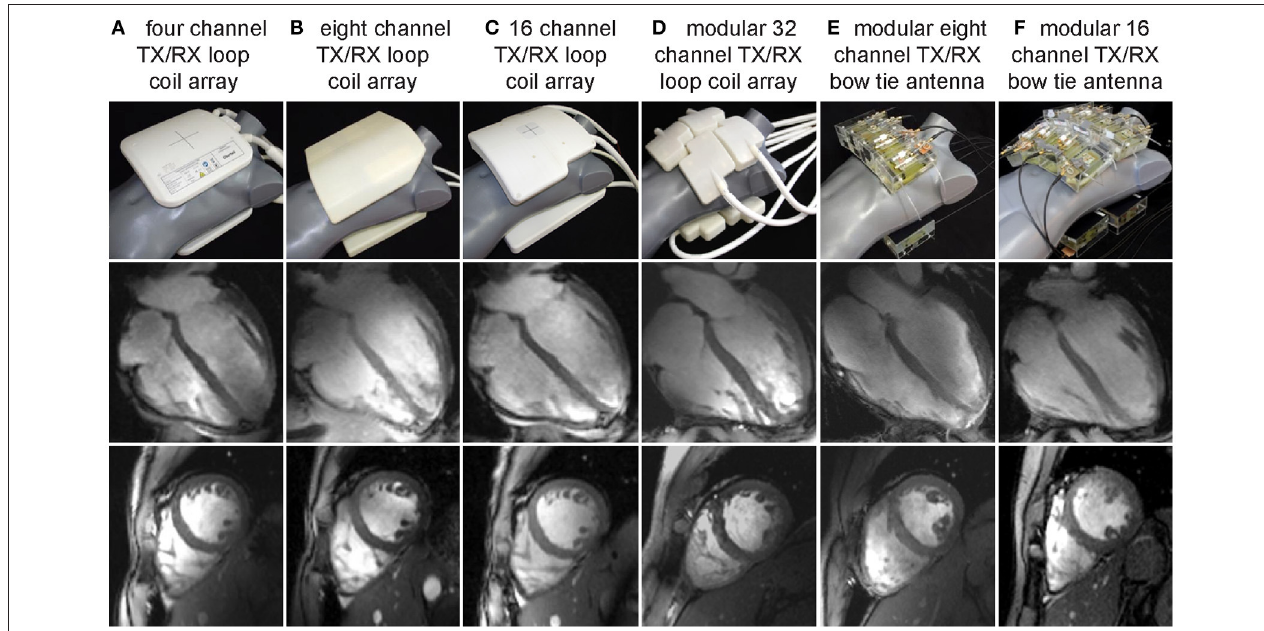
FIGURE 3 | Examples of multi-channel transceiver arrays tailored for cardiac MR at 7.0 T. Top: Photographs of cardiac optimized 7.0 T transceiver coil arrays including (left to right) (A) a four-channel, (B) an eight channel, (C) a 16 channel and (D) a 32 channel loop array configuration together with an (E) eight channel and (F) 16 channel bow tie antenna array. For all configurations the RF elements are used for transmission and reception. Center and bottom: Four chamber and short axis views of the heart derived from 2D CINE FLASH acquisitions using the RF coil arrays shown on the left and a spatial resolution of (1.4 × 1.4. × 4.0) mm 3 (from Niendorf et al. [113] with permission from John Wiley and